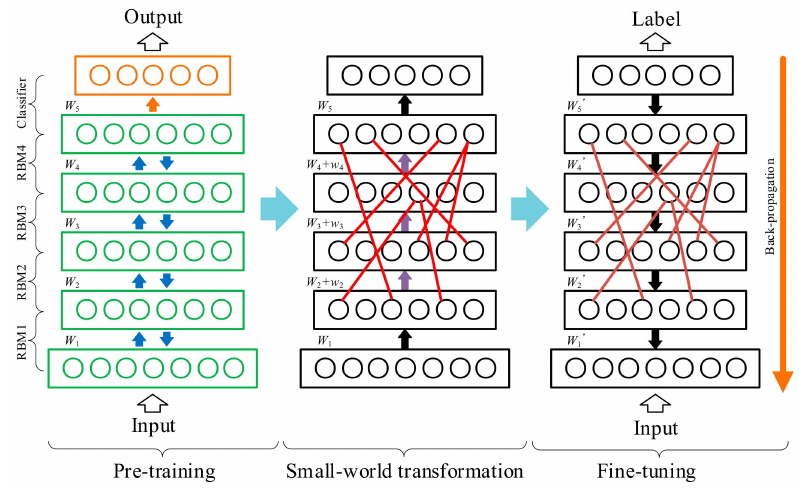
Figure 6. Three processes for training the proposed DSWNN